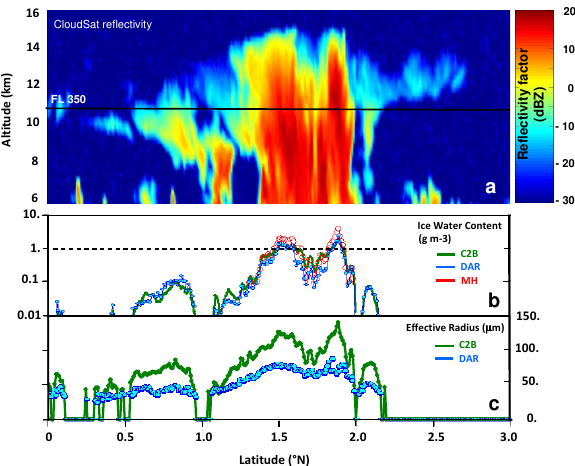
Fig. 6. (a) Vertical profiles of the equivalent reflectivity factor from CloudSat. (b, c) Variations of the retrieved IWC (log scale) and ef- fective radius, respectively, along the 10700m level. IWC is re- trieved from both the CloudSat 2B-IWC (C2B, green curve) and DARDAR (DAR, blue symbols) algorithms and from the relation- ship proposed by Matrosov and Heymsfield (2008) (MH; red sym- bols for reflectivities